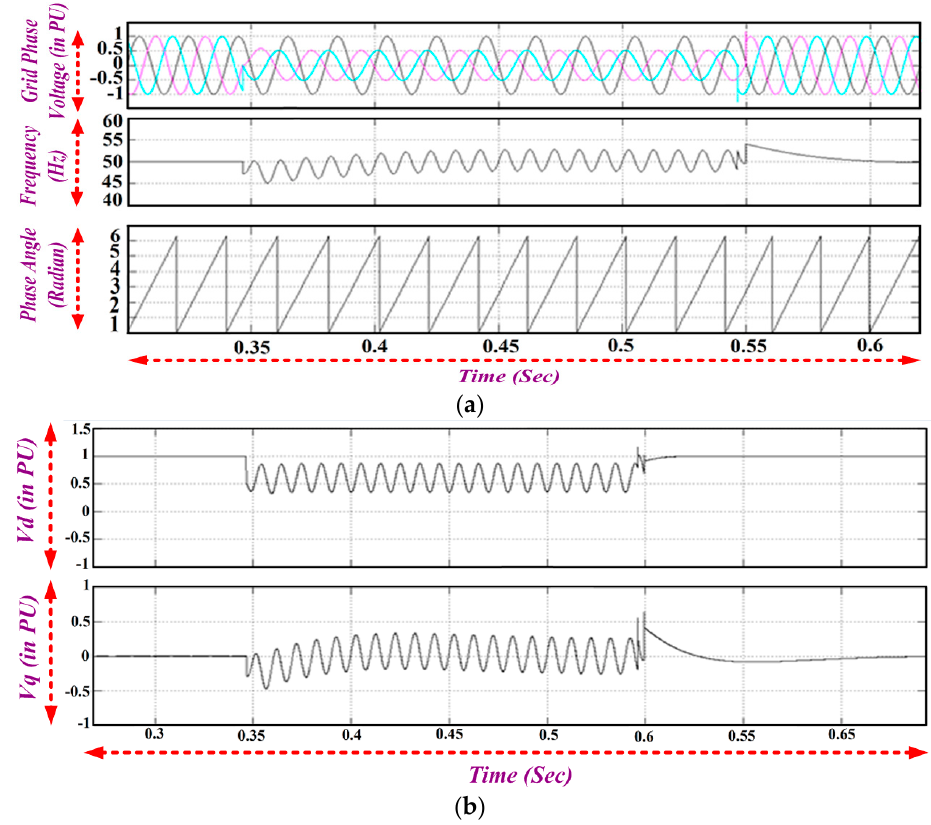
Figure 22. ( a ) Frequency and Phase Detection Variation during Unbalanced Grid Voltages; ( b ) q- axis and d- axis Voltage Magnitude during Unbalanced Grid Voltages.